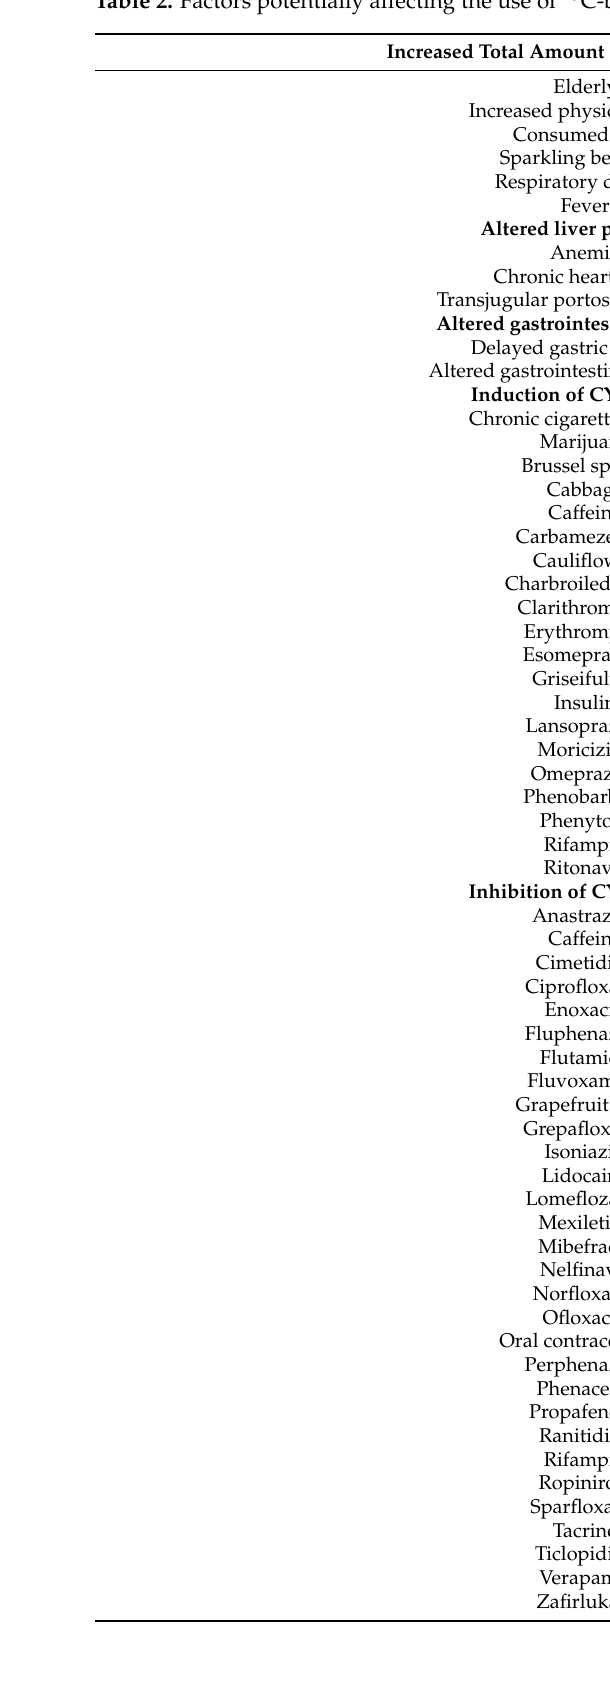
Table 2. Factors potentially affecting the use of 13 C-breath tests for the assessment of liver